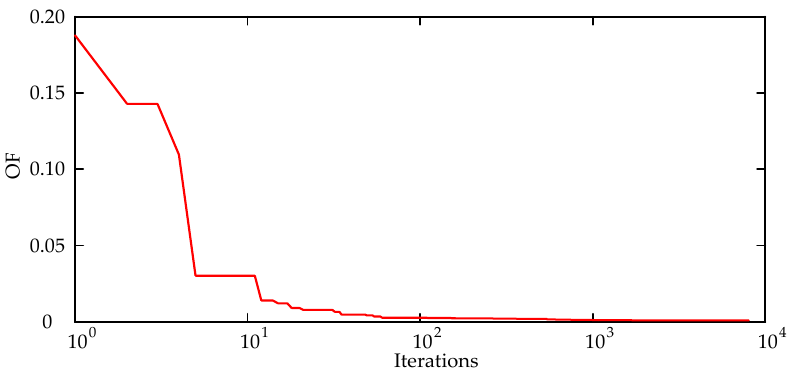
Figure 6. Convergence characteristic of the proposed ImCSA for parameter estimation of the DDM of RTC France silicon solar cell.